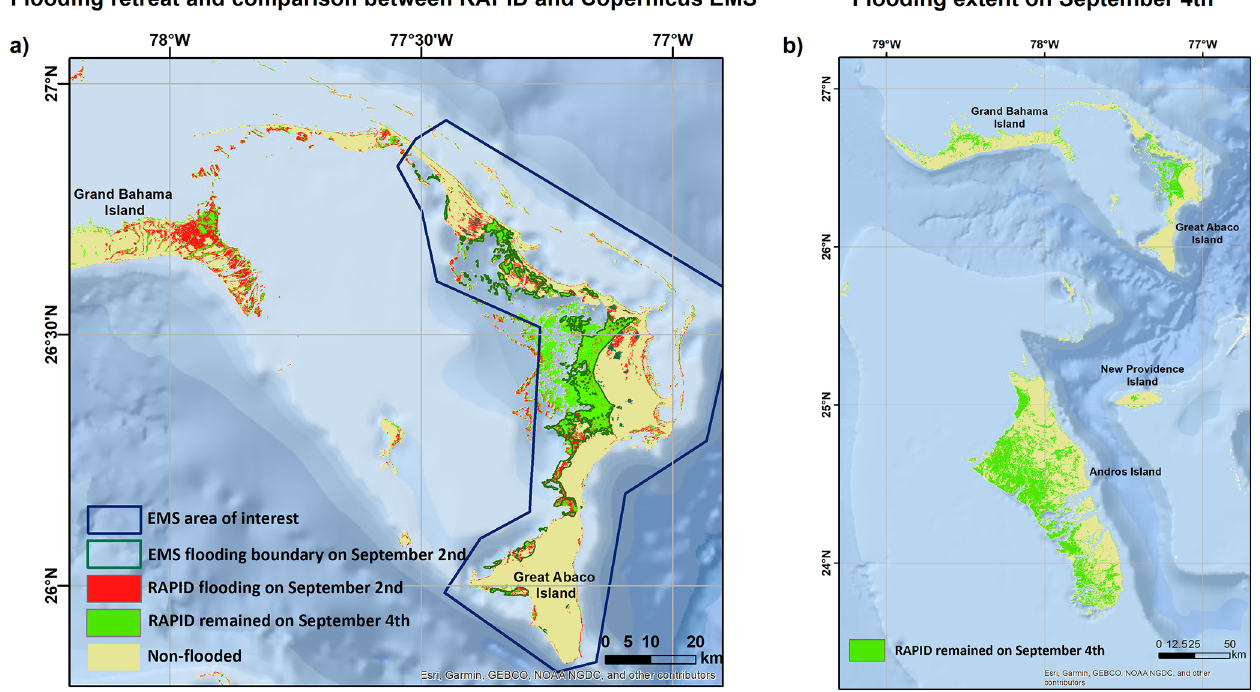
Figure 2. (a) Flooded and non-flooded areas on 2 and 4 September 2019 derived from the RAPID algorithm that processed SAR data from the Sentinel-1 overpasses, and flooded boundary on 2 September from Copernicus EMS. (b) RAPID flooding map for the entire northern and central Bahamas, for the 4 September 2019 Sentinel-1 overpass. For both images, ocean background is from World Ocean Base map (ESRI, 2014; list of contributors available at: http://downloads.esri.com/esri_content_doc/da/WorldOcean_ContributorsDA64.pdf, last